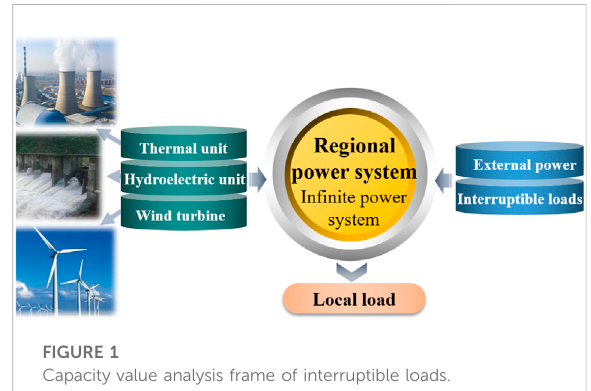
FIGURE 1 Capacity value analysis frame of interruptible